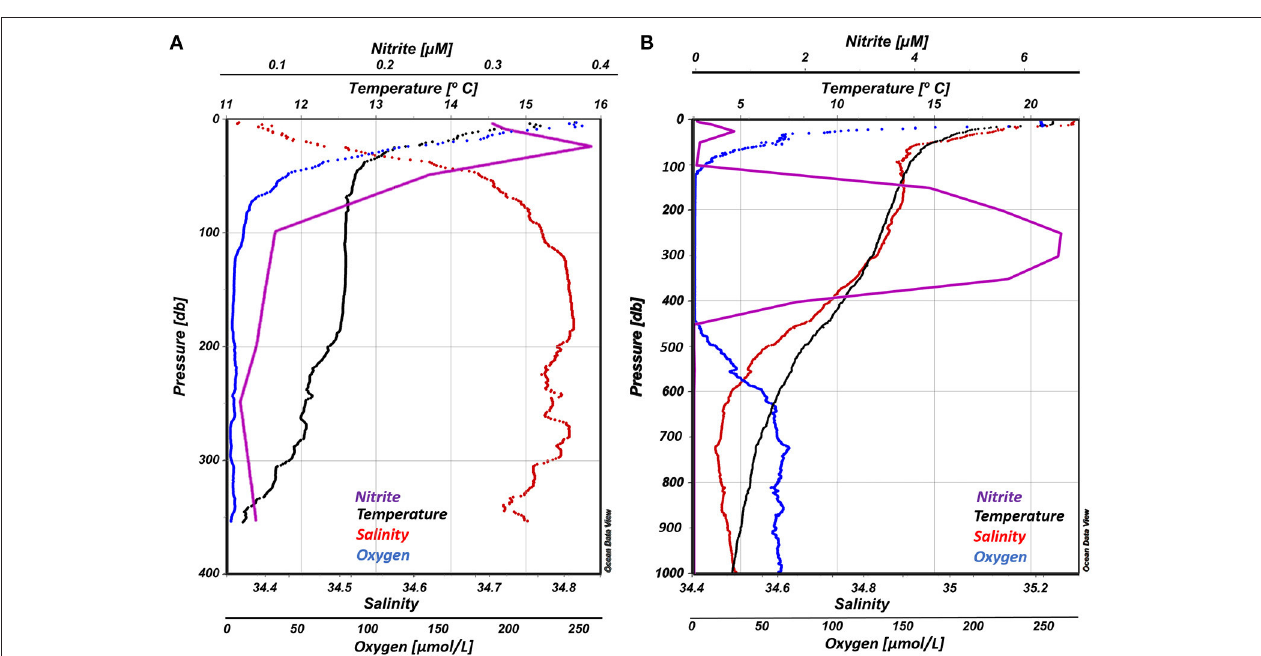
FIGURE 3 | Vertical profiles of temperature, salinity dissolved oxygen and nitrite for both ETSP OMZ stations in this study: (A) OMZ Station L6, left panel; (B) OMZ Station T3, right